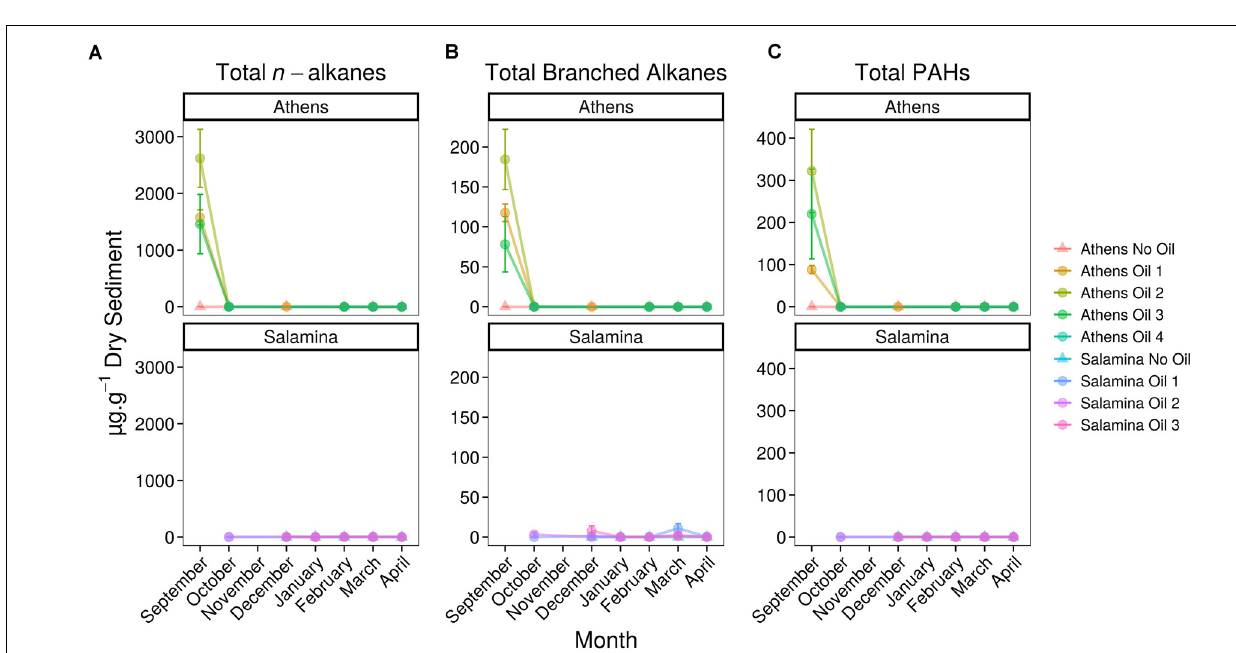
FIGURE 2 | Hydrocarbon concentrations (mean ± SE, n = 3) of the three contaminated sites (Athens Oil 1-3) and the uncontaminated control site (Athens No Oil), September 2017. (A) n -alkanes from C11 to C32 and the branched alkanes pristane and phytane. (B) PAHs from 2-ring naphthalene to 5-ring benzo[ a ]pyrene. No samples were taken for Salamina in September